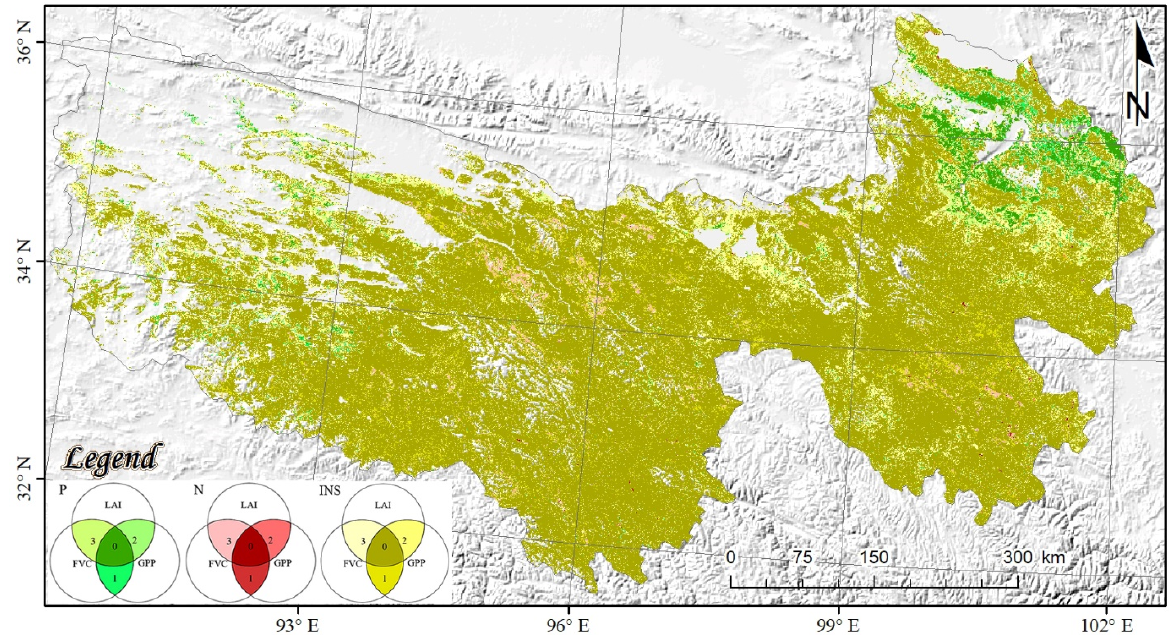
Figure 8. Spatial patterns of long-term trend comparison estimated from LAI, FVC, and GPP during the 2000–2018 growing season across the TRSR. The dark-colored pixels with ID 0 represent total agreement in the trend direction, i.e., total agreed in positive (P0), negative (N0), and insignificant changes (INS0), while light-colored pixels with ID 1, 2, or 3 represent total disagreement, i.e., total disagreed in positive (P1, P2, or P3), negative (N1, N2, or N3), and insignificant changes (INS1, INS2, or INS3), and the meanings of each ID are shown in Section 2.3.4.